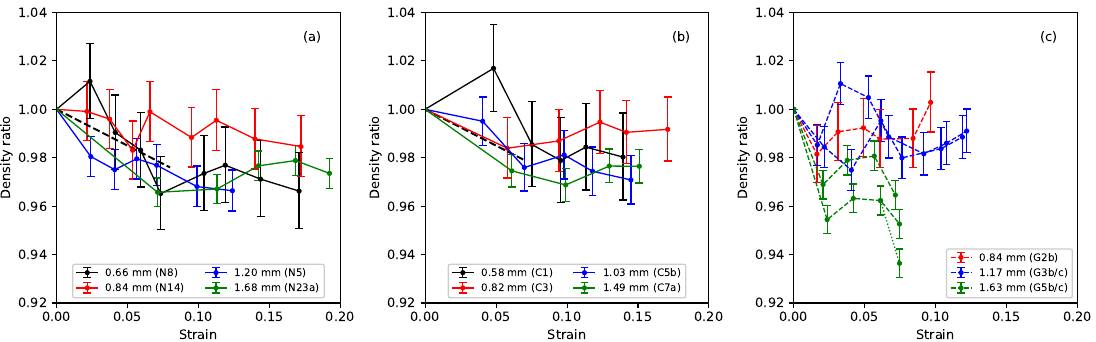
Figure 5. The ratio of the bulk density of the stretched strings to that of the unstretched strings, plotted against the strain, for ( a ) nylon, ( b ) fluorocarbon, and ( c ) gut. The error bars indicate the range of values that could be expected due to the resolution limit of the manual micrometer used to measure the string diameter. The dashed lines in Plots ( a , b ) show the expected reduction in the density ratio for small values of strain